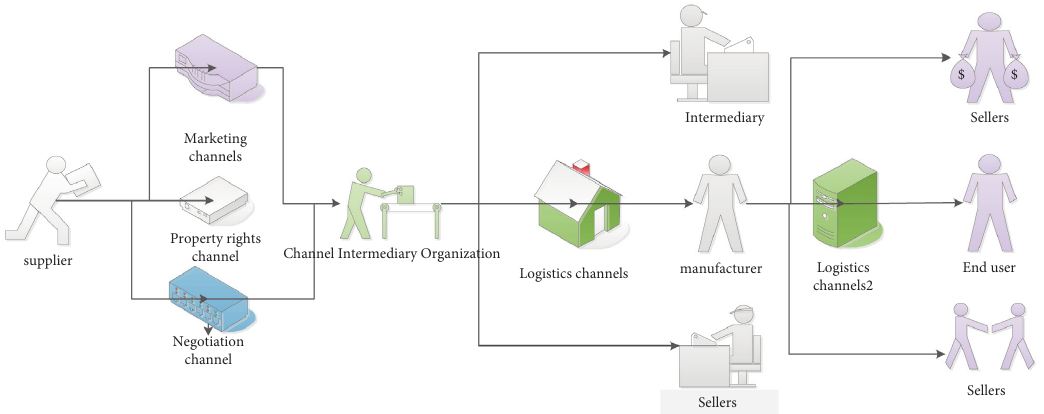
Figure 2: Supply chain channel